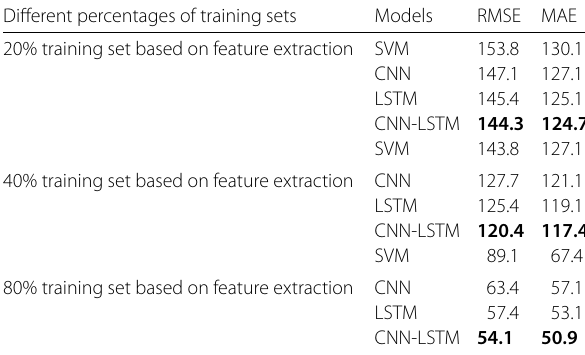
Table 2 the impact of different training sets on the performance of different models Different percentages of training sets